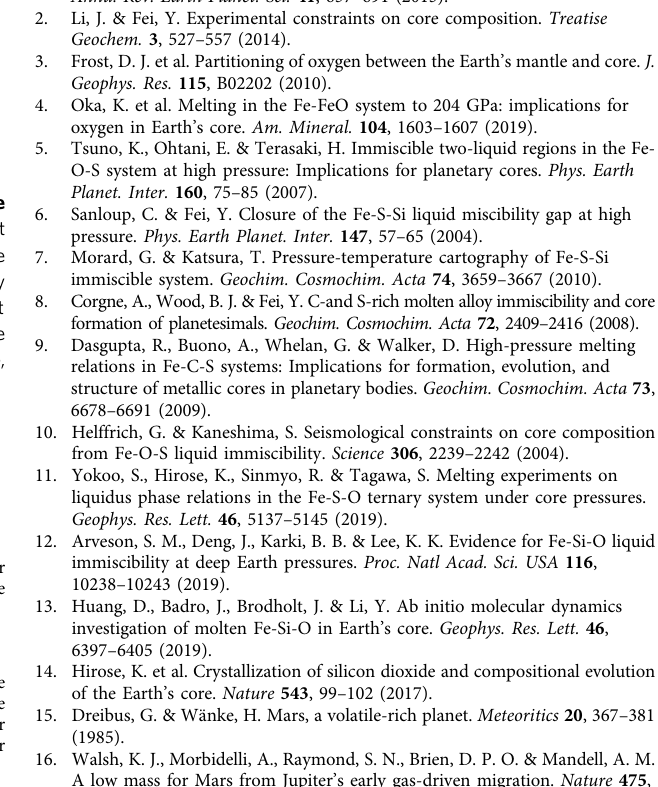
Compositions of the bulk outer core and the E ’ layer . If the strati fi cation in the uppermost outer core is caused by the liquid immiscibility (Fig. 3), it constrains the chemical compositions of the BOC and the overlying E ’ layer. We refer to ref. 18 for the density and sound velocity of liquid iron alloyed with S, H, C, Si, and O. Their calculations along the relatively low, isentropic temperature pro fi le with T ICB = 4800 K at the inner core boundary were adopted because hydrogen is known to reduce the melting temperature of iron substantially 57,67 .